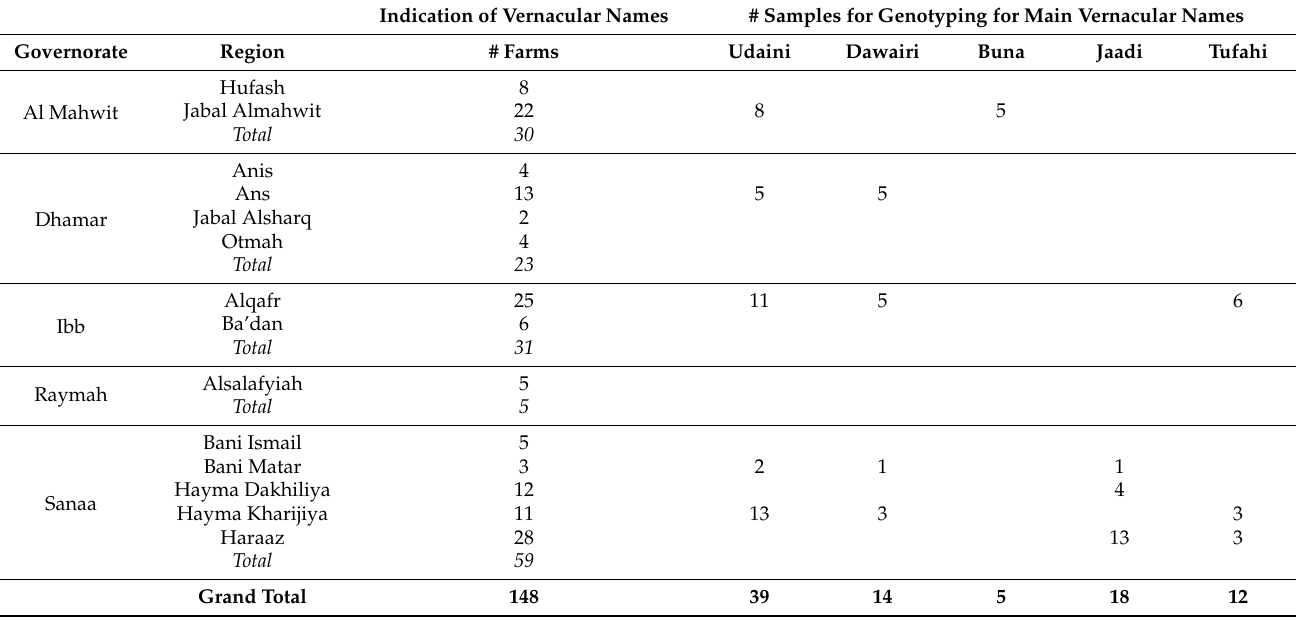
Table 1. Number of coffee farms indicating vernacular names and coffee trees sampled for genotyping per governorate and region in Yemen.